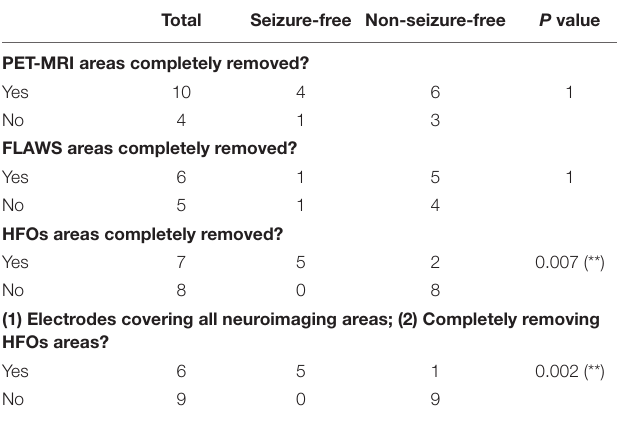
TABLE 2 | Correlation with outcome individually or